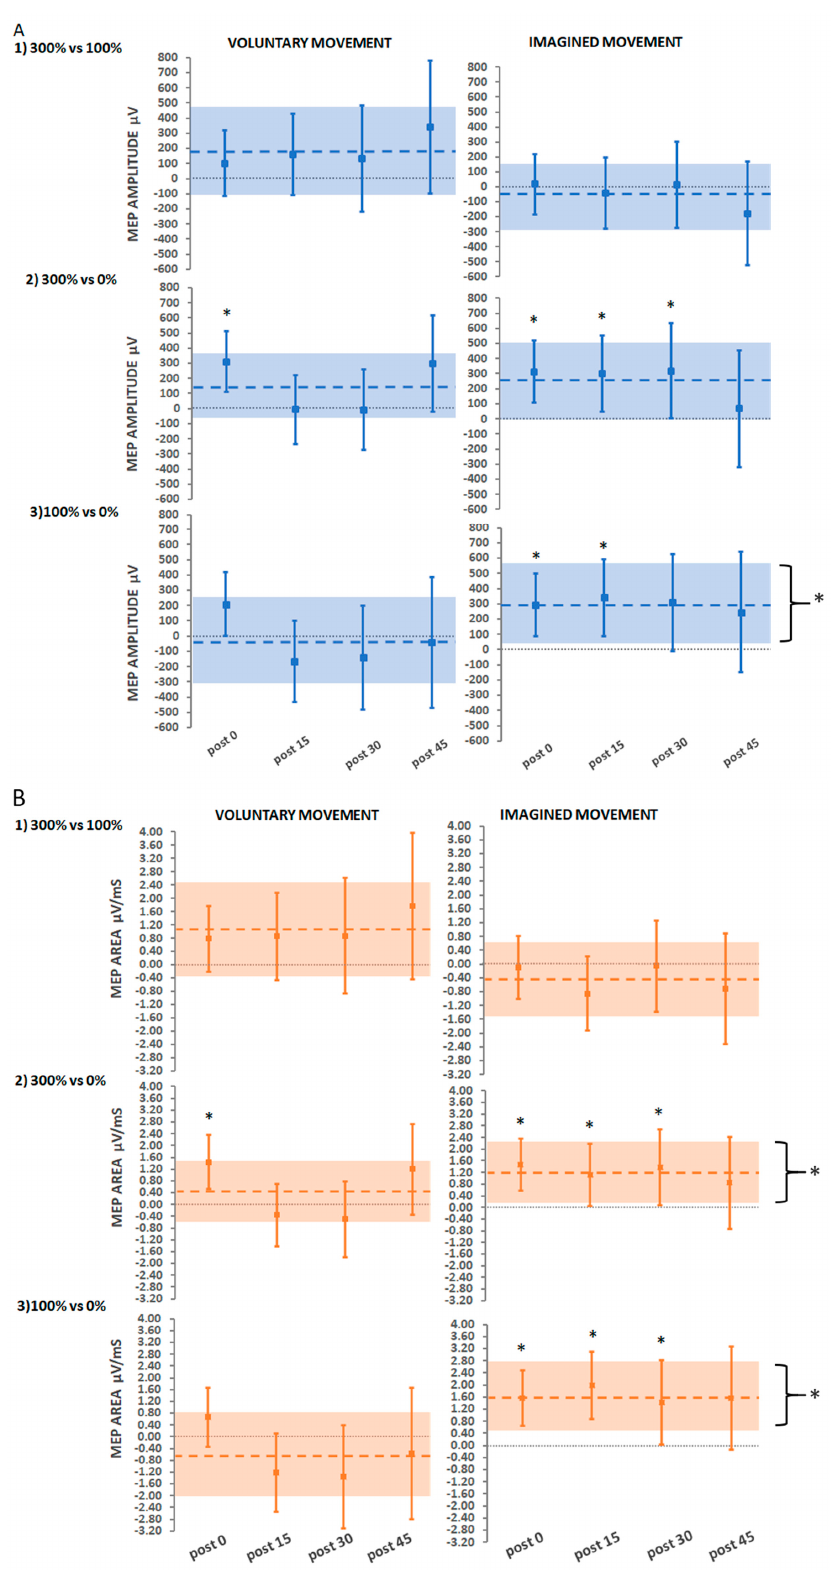
Figure 6. Estimated adjusted effect differences between stimulation intensity levels delivered during voluntary movement and imagined movement on ( A ) MEP amplitude and ( B ) MEP area, at each post-intervention time-point and averaged over time. Error bars depict 95% CIs. Dashed lines depict estimates averaged over time with a shaded bar for 95% CIs. * indicates significant effects ( p < 0.05).